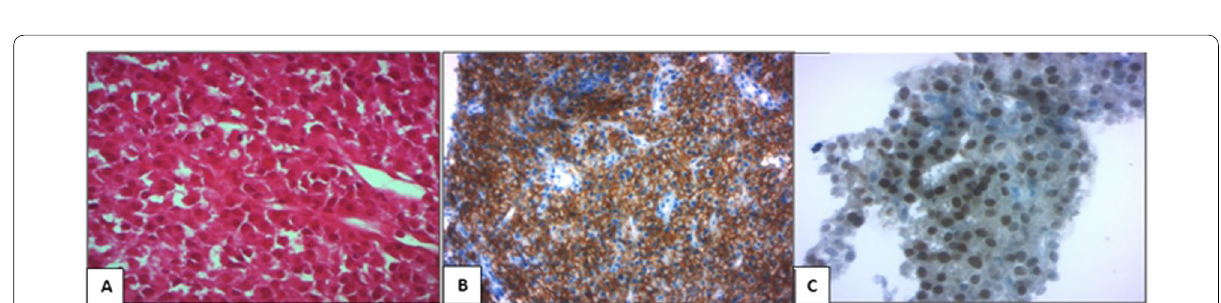
Fig. 1 Chest computed tomography scan: mediastinal window. 36 from the thymus (yellow arrows)